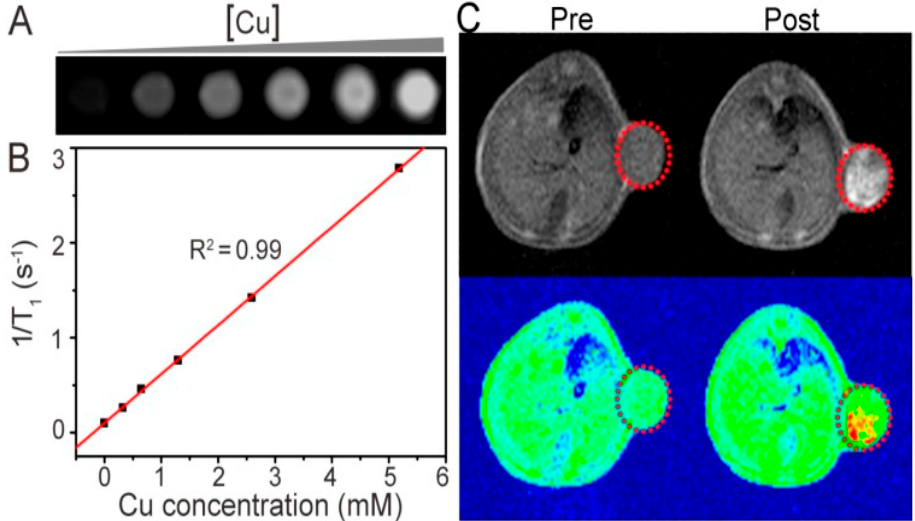
Figure 5. ( A ) MRI of the Cu-TCPP aqueous solution with different concentrations. ( B ) Plots of the 1/T1 value of the Cu-TCPP under concentration dependence. ( C ) mouse MRI before and after intratumoral injection of the Cu-TCPP. Red circles indicate the position of the tumor. Reprinted with permission from Ref. [41]. Copyright 2018, Ivyspring International Publisher.